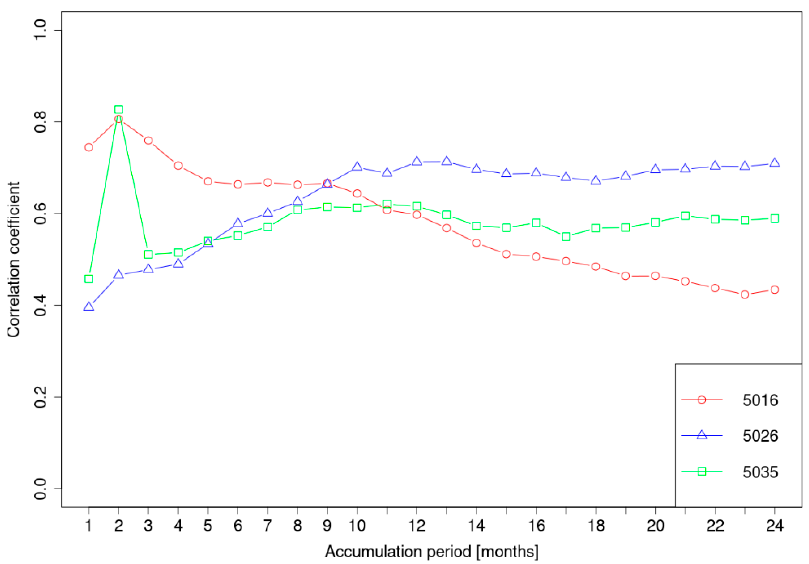
Figure 6. SPEI-SSI correlation for different SPEI accumulation periods in stations 5016, 5026, and 5035.